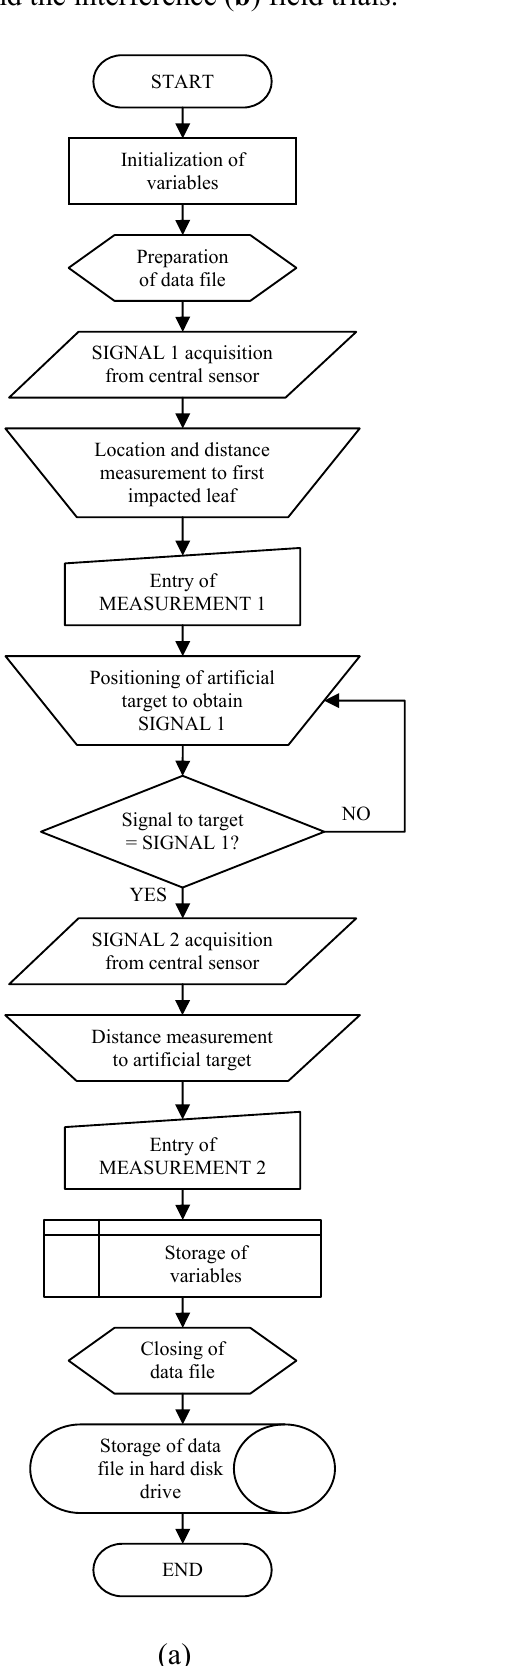
Figure 6. Flux diagrams of the programs designed for the field distance measurement ( a ) and the interference ( b ) field